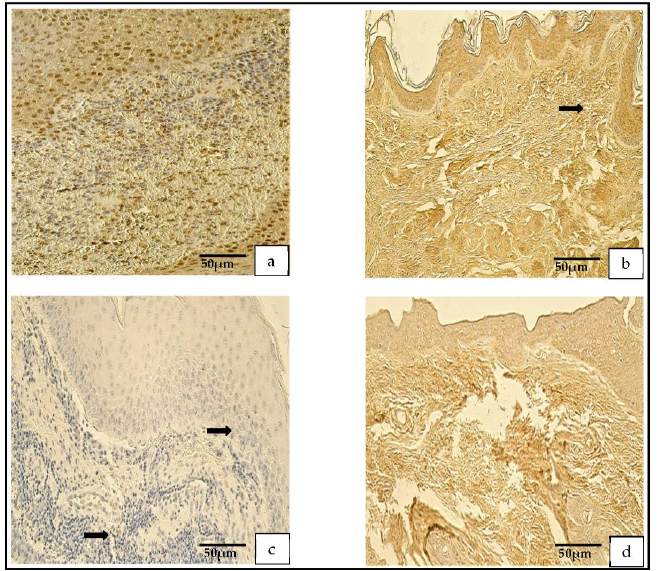
Figure 4. ( a – d ) Immunohistochemical micrographs. ( a ) Cholesteatoma. Numerous-to-abundant MMP–2-positive cells in the matrix and numerous in the perimatrix, MMP–2 IHC. ( b ) Skin . Numerous MMP–2-positive cells in the epithelium, a few (arrow) in the connective tissue, MMP–2 IHC. ( c ) Cholesteatoma . Occasional MMP-9-positive cells in matrix and the perimatrix (arrows), MMP-9 IHC. ( d ) Skin . A moderate number of MMP-9-positive cells in the epithelium and connective tissue, MMP-9 IHC.